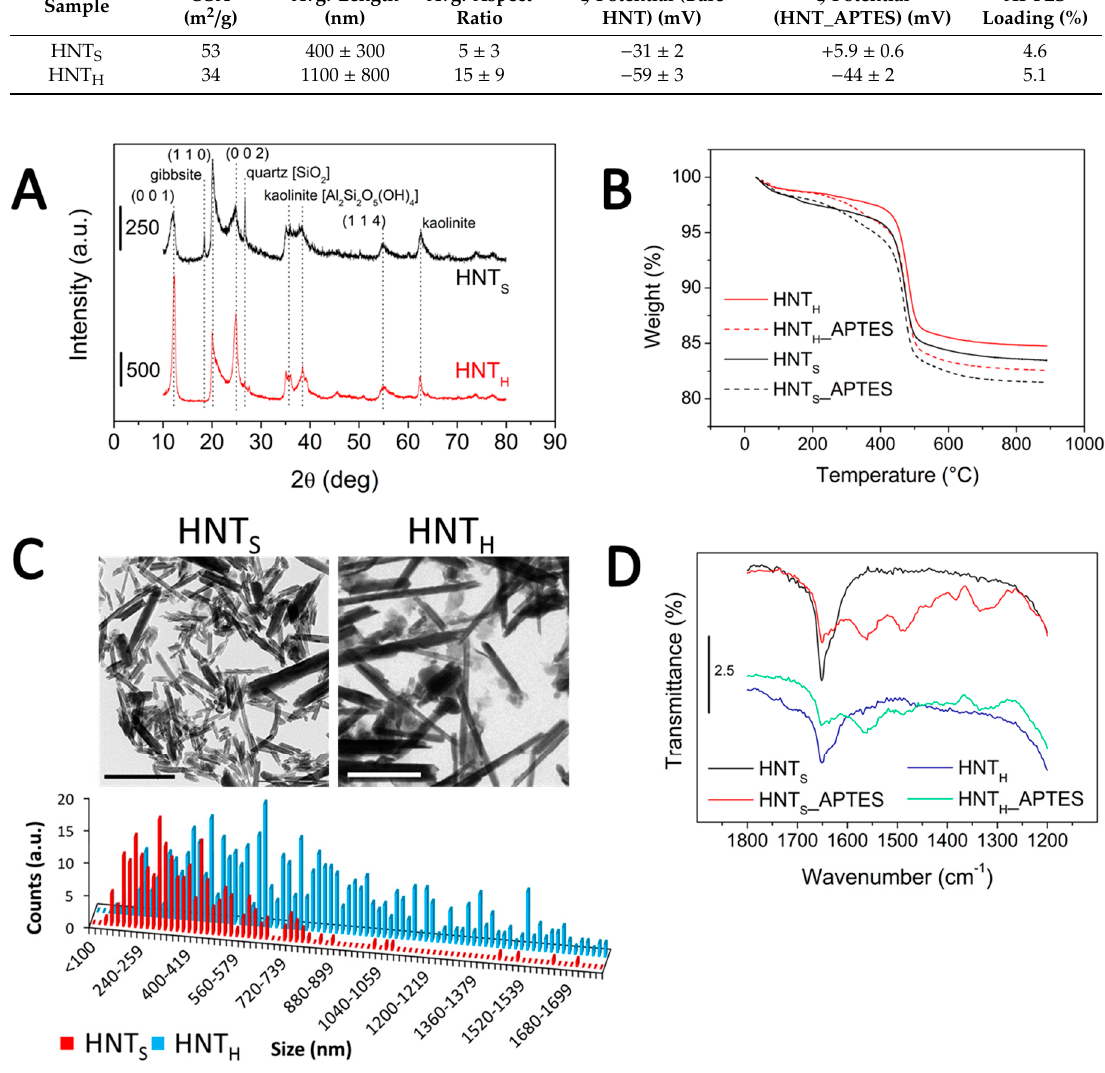
Figure 1. Characterization of adopted HNT powders: ( A ) XRD patterns with indexing of the halloysite peaks and main impurities; ( B ) TGA curves; ( C ) TEM images (scale bar: 1 µm); and ( D ) FTIR spectra of bare and APTES-modified fillers. Table 1. Physicochemical properties of bare and functionalized HNT: specific surface area (SSA), average length and aspect ratio, ς -potential at spontaneous pH, and APTES loading from TGA.